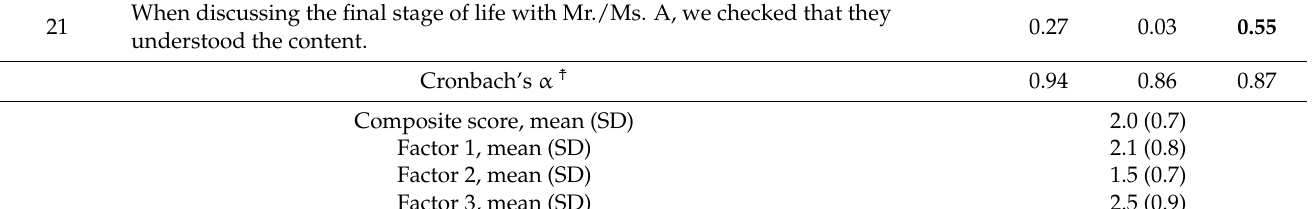
Table 5. The final version of Advance Care Planning Practice Inventory (ACP-PI). Instruction text: Circle the Corresponding Number to Indicate Which of the Following Items Have Been Conducted in Relation to Mr./Ms. A. No.